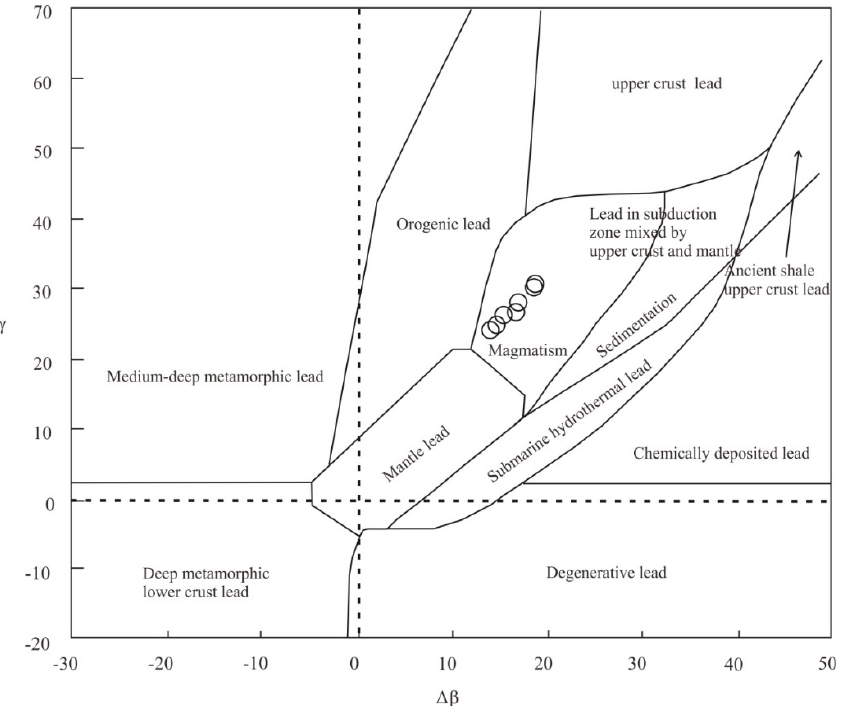
Figure 10. Δγ — Δβ genetic discrimination diagram of lead isotope for the Qiyimuchang lead–zinc Figure 10. ∆ γ — ∆ β genetic discrimination diagram of lead isotope for the Qiyimuchang lead–zinc deposit (base map from [49]). deposit (base map from